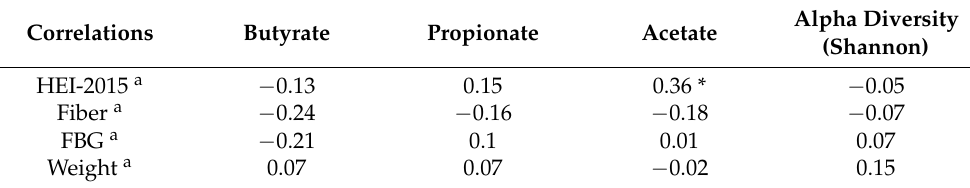
Table 3. Baseline correlations between dietary intake, fasting glucose, weight, and SCFA and alpha Table 3. Baselinecorrelationsbetweendietaryintake, fastingglucose, weight, andSCFAandalphadiversity. diversity.